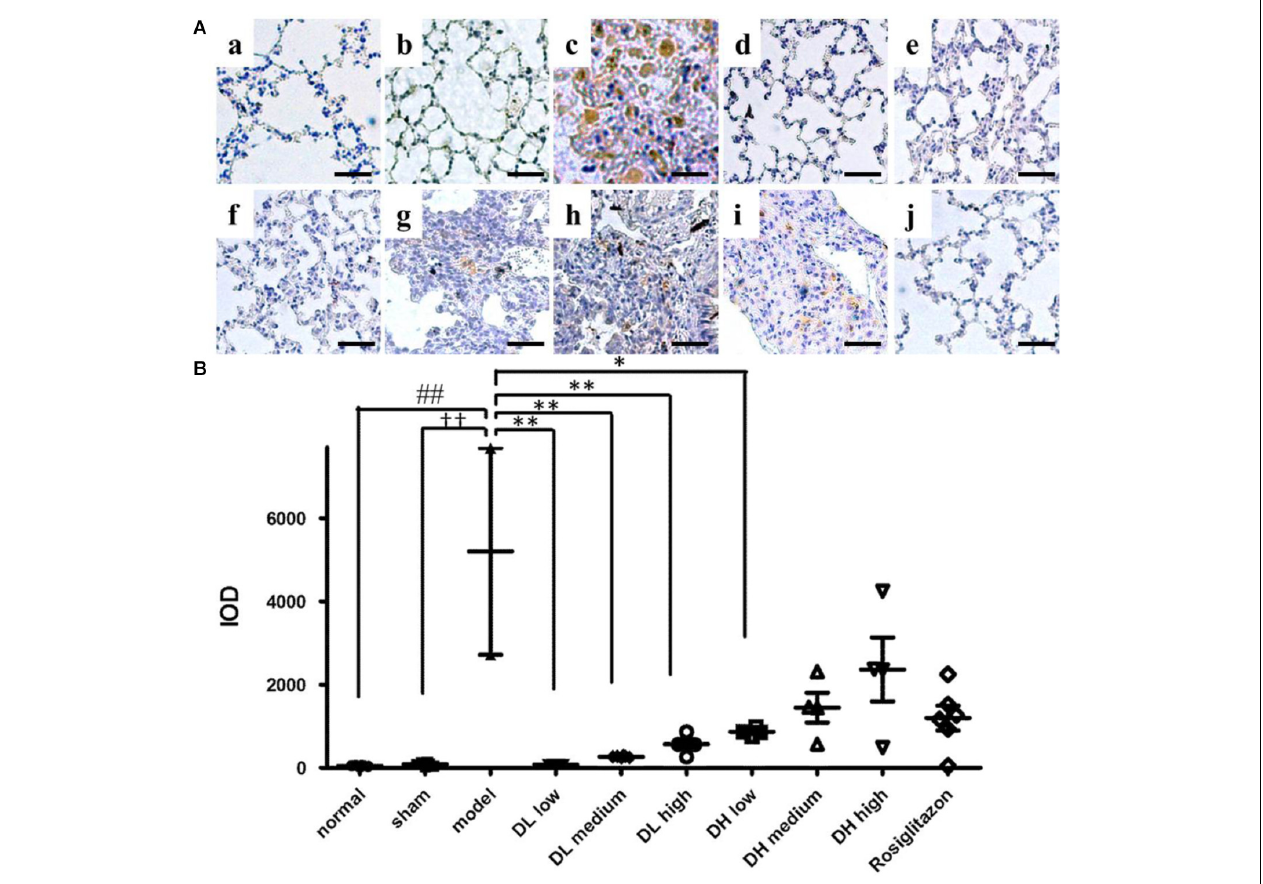
FIGURE 5 | Effects of DLP and DHP on TGF- β receptor type II expression in lung tissues of mice. (A) Representative images of immunohistochemical staining for T β RII protein in lung tissue samples. Scale bar = 50 µ m. Panel indicators: a, normal; b, sham; c, model; d, DL low dose; e, DL medium dose; f, DL high dose; g, DH low dose; h, DH medium dose; i, DH high dose; j, ROS. (B) Integral optical density of T β RII-positive expression in lung tissue samples. IOD: integral optical density. Results are expressed as the mean ± standard deviation. ## P < 0.01 versus the normal group; †† P < 0.01 versus the sham group; ∗∗ P < 0.01 and ∗ P < 0.05 versus the model